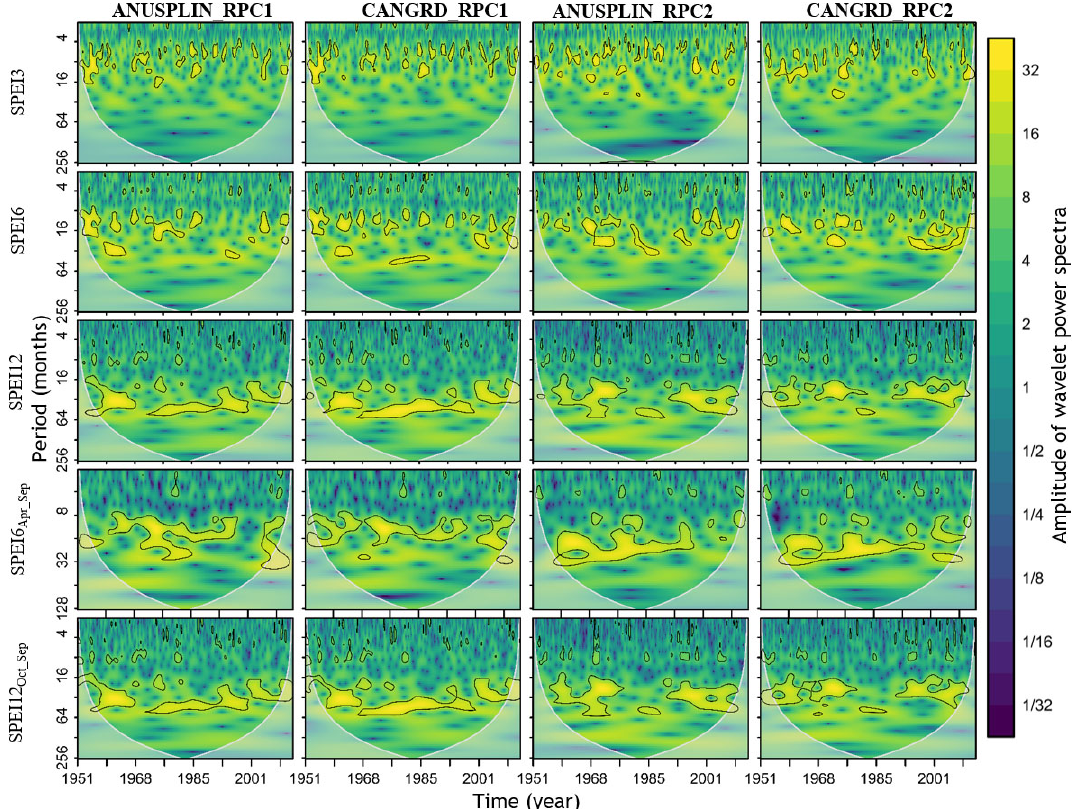
Figure 8. Wavelet power spectrum of the time series (RPCs) shown in Fig. 6. The black contour designates the 95% confidence level against red noise, and the cone of influence (COI), where edge effects might distort the picture, is shown as a lighter grey shade.